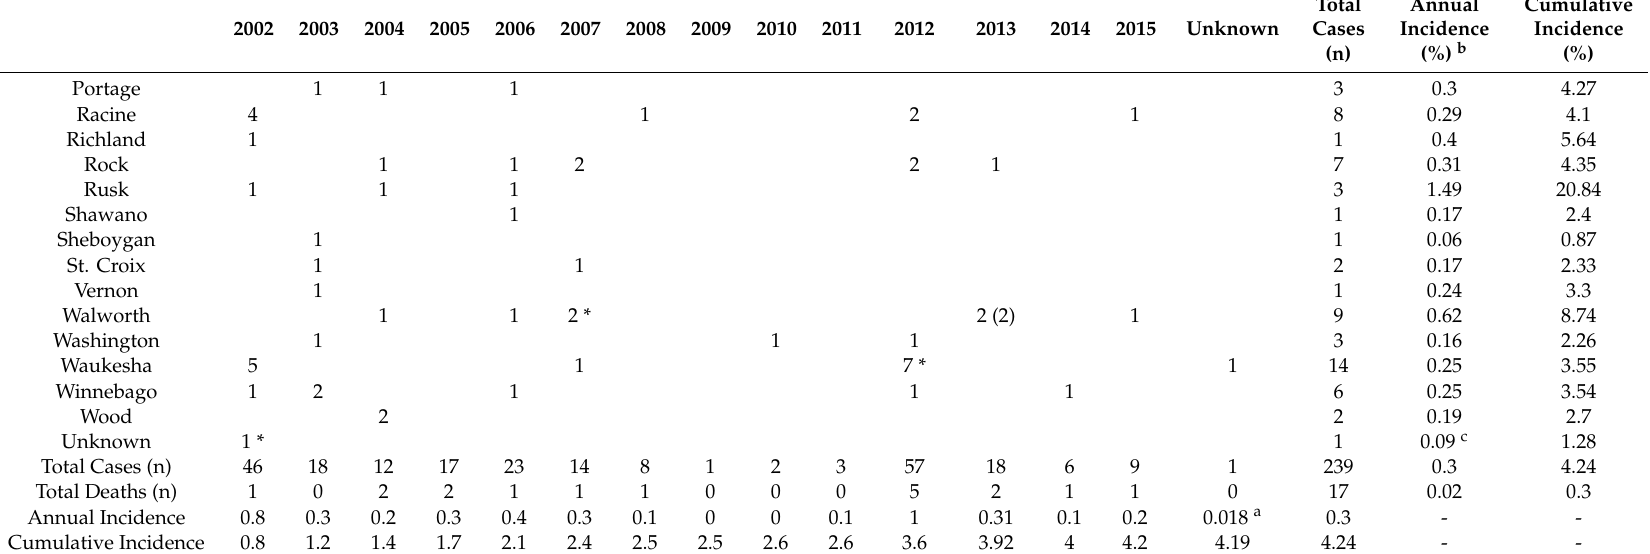
a Population based on average from 2002 to 2015 Wisconsin annual values provided by U.S. Census Data; incidence per 100,000 individuals. b County population values based on most recently provided estimate (year: 2013) by U.S. Census Data. c Calculation based on average county population (78261) based on 2013 U.S. Census County Data. Values contained within parenthesis indicate probable cases; each asterisk (*) indicates numbers of human deaths. State population values provided from U.S. Census